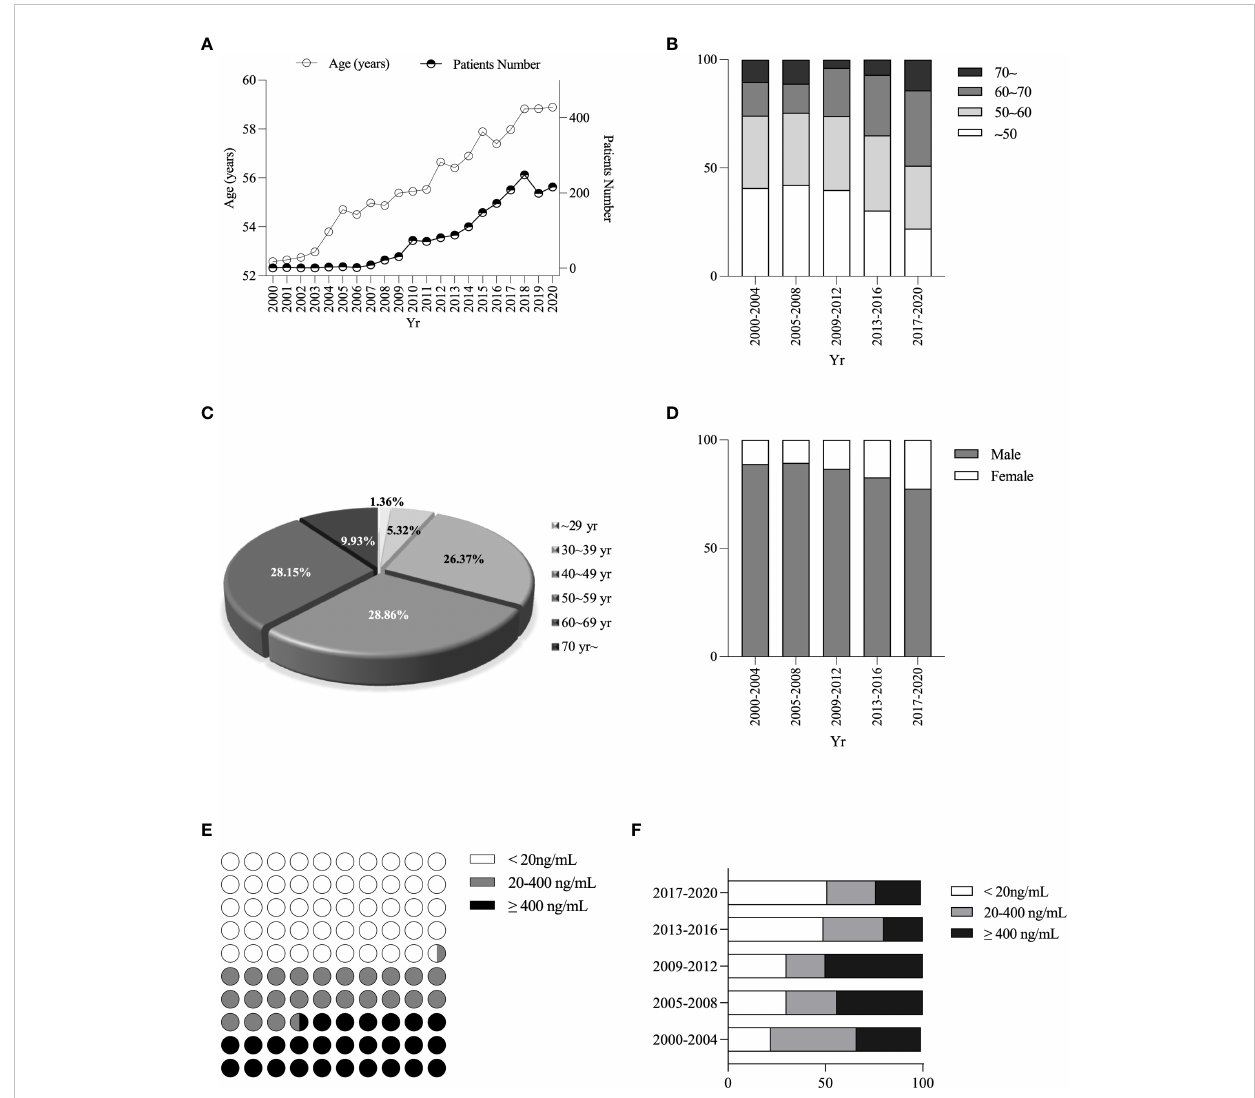
FIGURE 2 Changes in age, sex, and different AFP levels ratio among PLC patients. Changes in age of diagnosis of PLC patients (A) . Changes in age composition ratio (B) . Percentage of PLC patients ’ age (C) . Changes in sex ratio (D) . Strati fi cation of AFP levels (E) . Changes in the proportion of different AFP strati fi cations (F)